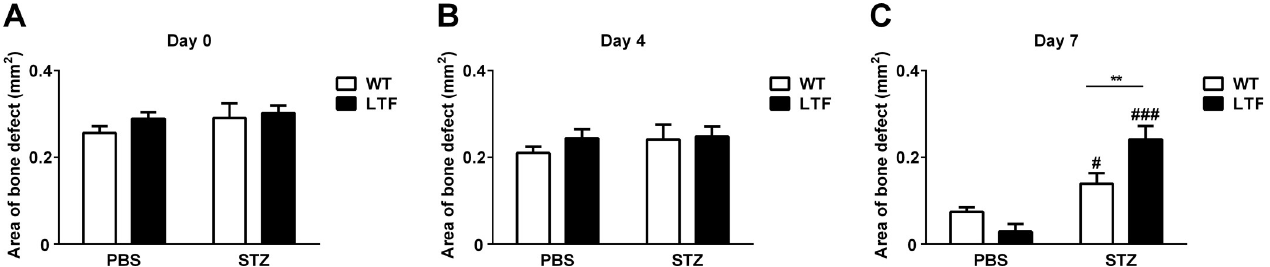
Fig 2. Effects of TF levels on diabetes-induced bone repair delay. (A-C) The serial quantification of bone defects at the injured site 0 (A), 4 (B), and 7 (C) days after femoral bone defects in WT (white bars) and LTF (black bars) mice treated with or without STZ, as assessed by qCT. Data represent the mean ± SEM of 6 mice. # P < 0.05, ### P < 0.001, significantly different from PBS-treated control mice; �� P < 0.01, between WT and LTF mice.